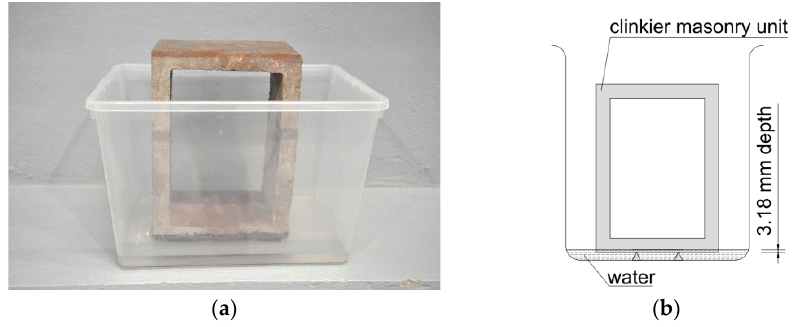
Figure 2. Determination of IRA: ( a ) view of the specimen during test; ( b ) scheme of the test. The water level was adjusted to 3.18 ± 0.25 mm (1/8 inch) above the contact plane of the test piece with the water. It was kept constant during the whole test (60 s). After re- moving the element from the water, it was carefully wiped off and weighed again. In total, five samples were tested in accordance with the recommendations of the standard [54]. The determined average value of IRA was 6.54 g/min./30 in. 2 , with a coefficient of variation CoV = 12.3%. As for the masonry clinker units, the value of IRA turned out to be slightly inflated. For these types of units, which fall into the group of low-absorption or low-suction units, the maximum IRA value should not exceed 5 g/min./30 in. 2 [55]. The IRA value determined for the analyzed clinker units was close to the lower limit of the range, characterizing the masonry units as middle-absorption or middle-suction